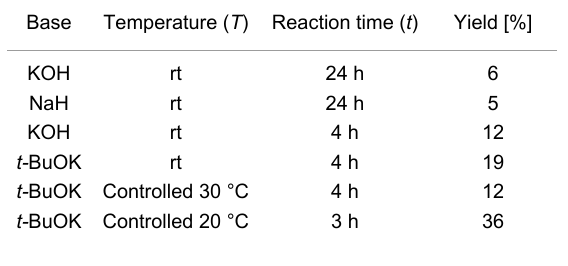
Table 1: Optimized experimental conditions for the synthesis of com- pound 7 .